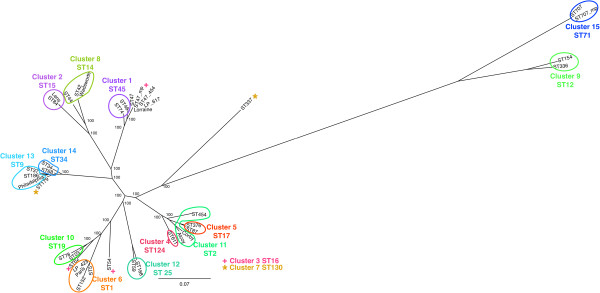
A maximum likelihood tree based on the SNP differences between all 27 L. pneumophila genomes sequenced as part of this work and 5 additional genomes from GenBank (Alcoy, Corby, Lens, Paris, Philadelphia). Also included are four additional genomes from external sources (LP_423(ST1), Lorraine (ST47), LP_617 (ST47), Wadsworth (ST42)) used for intra ST-comparison. The internal nodes are labelled with the bootstrap values. The data for this tree can be viewed at
http://purl.org/phylo/treebase/phylows/study/TB2:S15085.